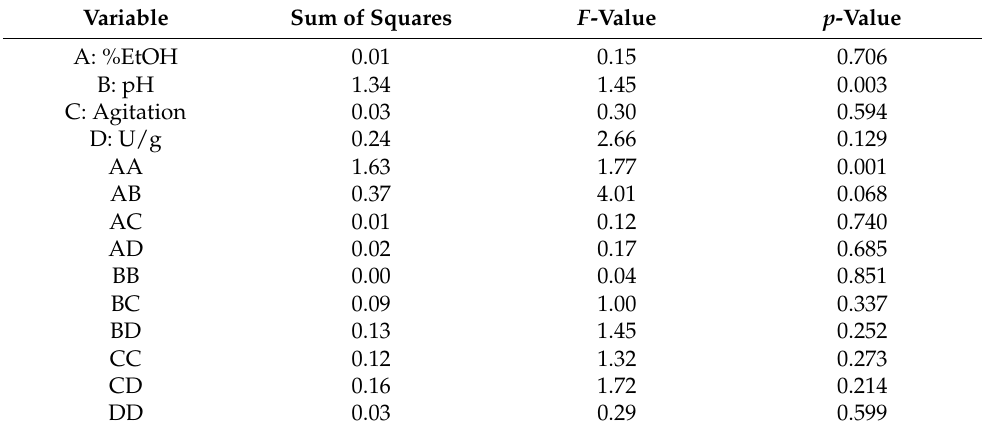
Table 3. Results from the BBD–RSM of the anthocyanins extracted from the açai samples.